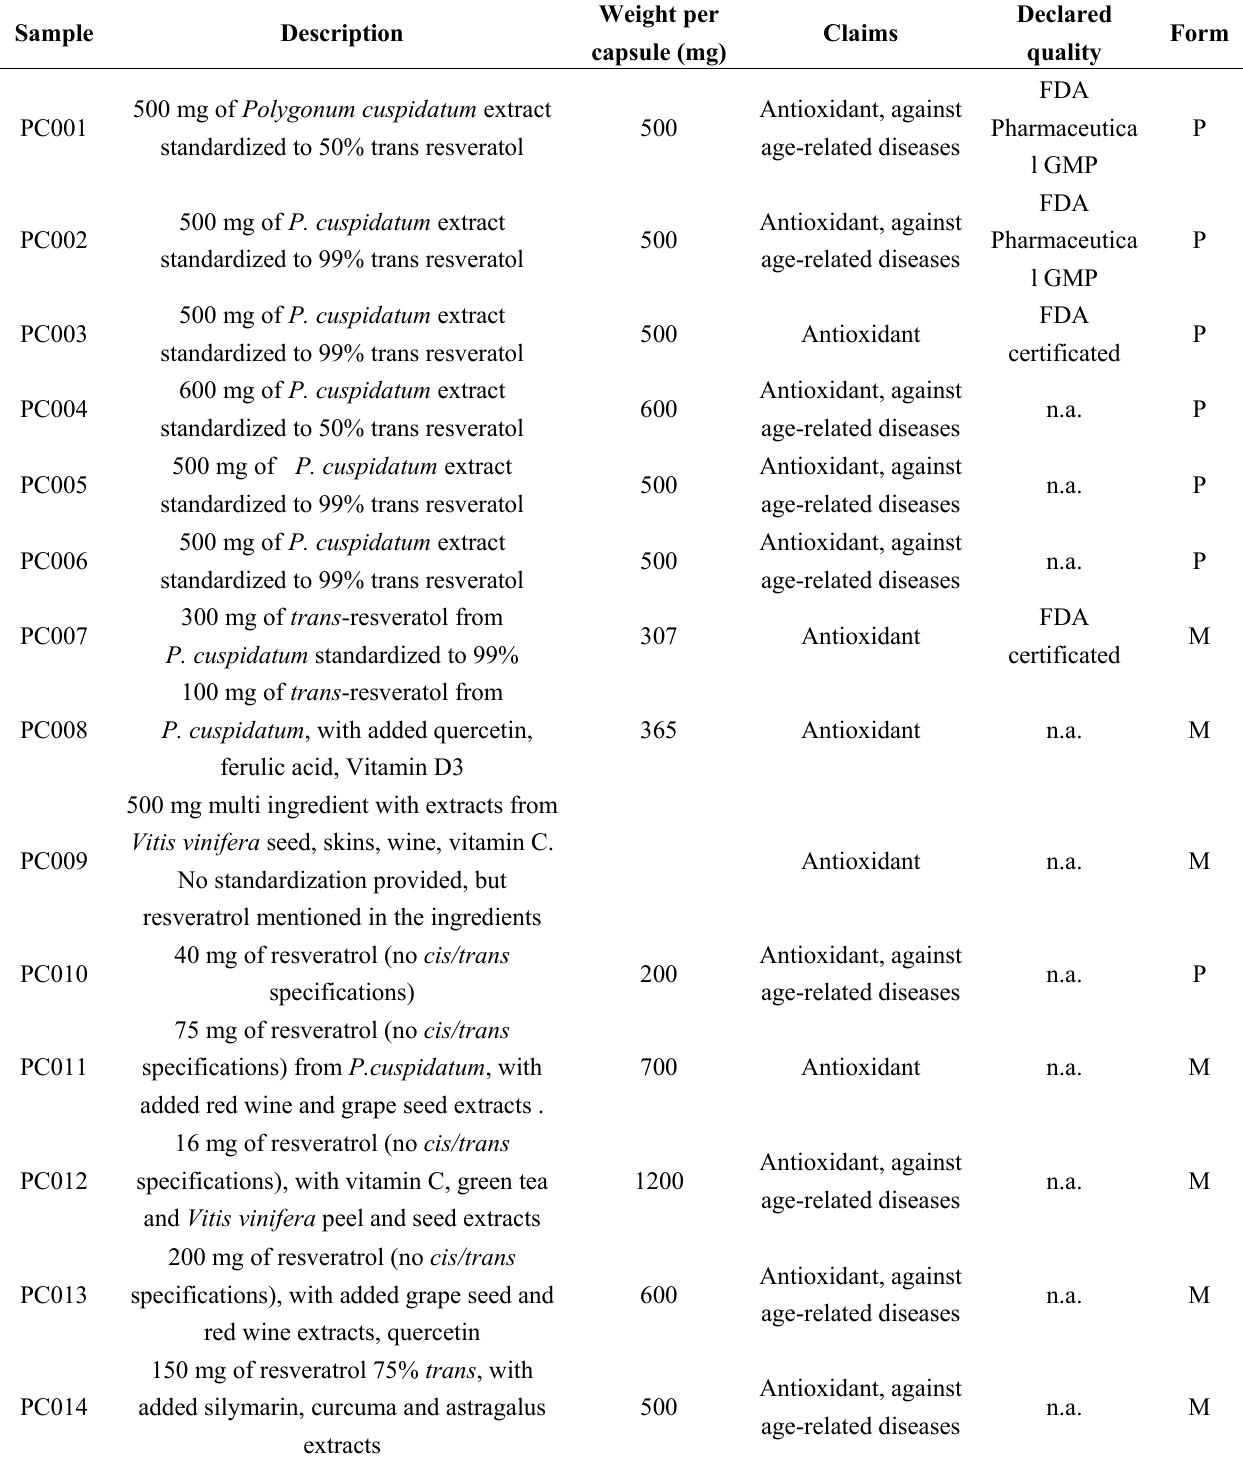
Table 1. Description and on-label information of 14 resveratrol food supplements purchased on line.